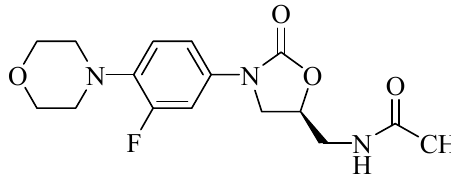
Figure 2. Antibacterial linezolid (PNU-100766).